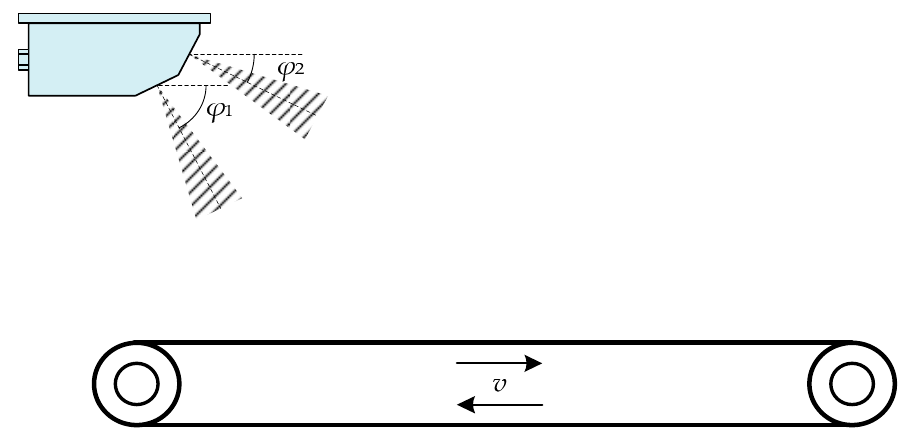
Figure 7. Schematic diagram of traditional speed calibration method for the train-borne DRS by using a moving pavement simulator.